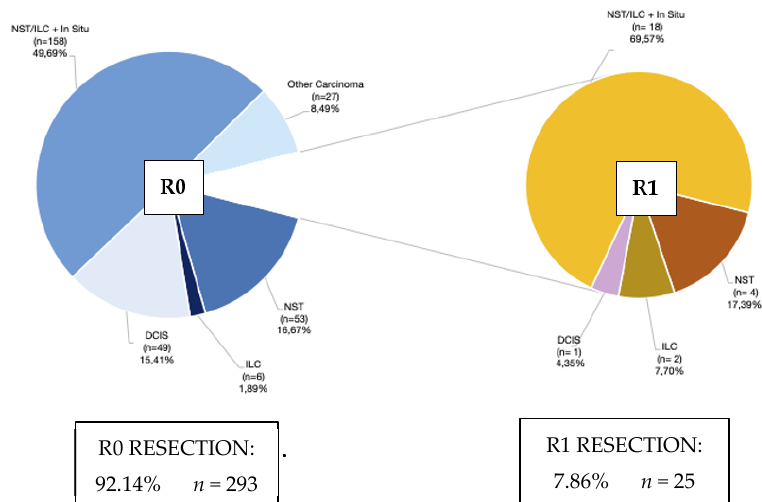
Figure 1. Pathological characteristics of patients with invasive breast cancer and ductal carcinoma in situ: R0 versus R1 resection. Abbreviations: NST = Invasive Carcinoma of No specific Type, ILC = Invasive Lobular Carcinoma, Other Invasive Carcinoma: Mucinous, Apocrine, Tubular, Papillary, Metaplastic, Neuro-endocrine subtypes.